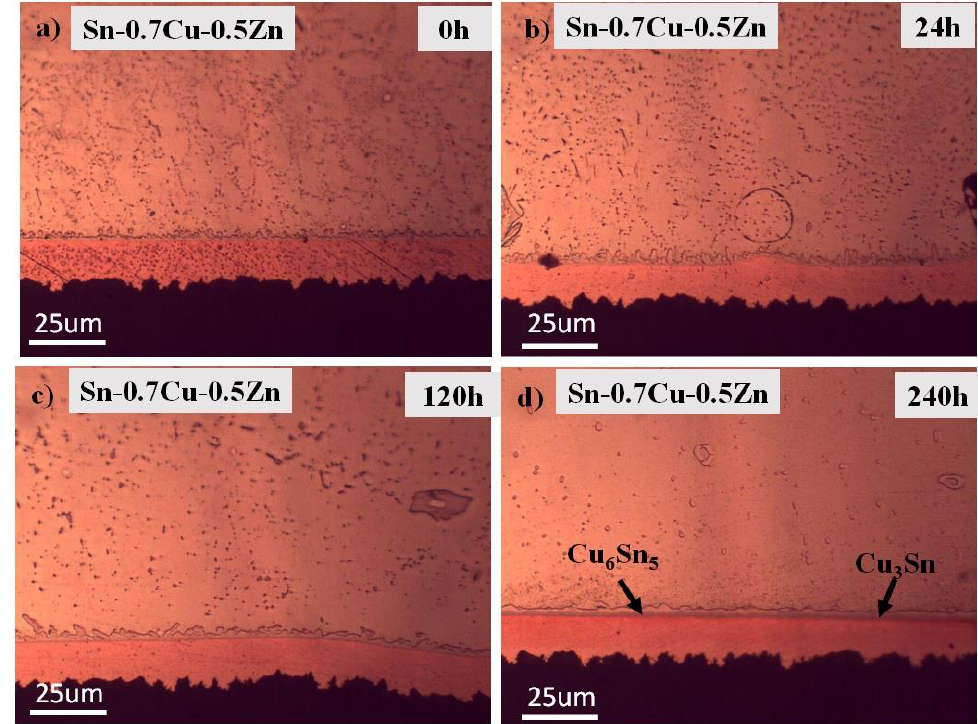
Figure 8. Microstructure of Interfacial IMC of Sn-0.7Cu-0.5Zn after annealing at ( a ) 0 h, ( b ) 24 h, ( c ) 120 h and ( d ) 240 h at 180 °C.